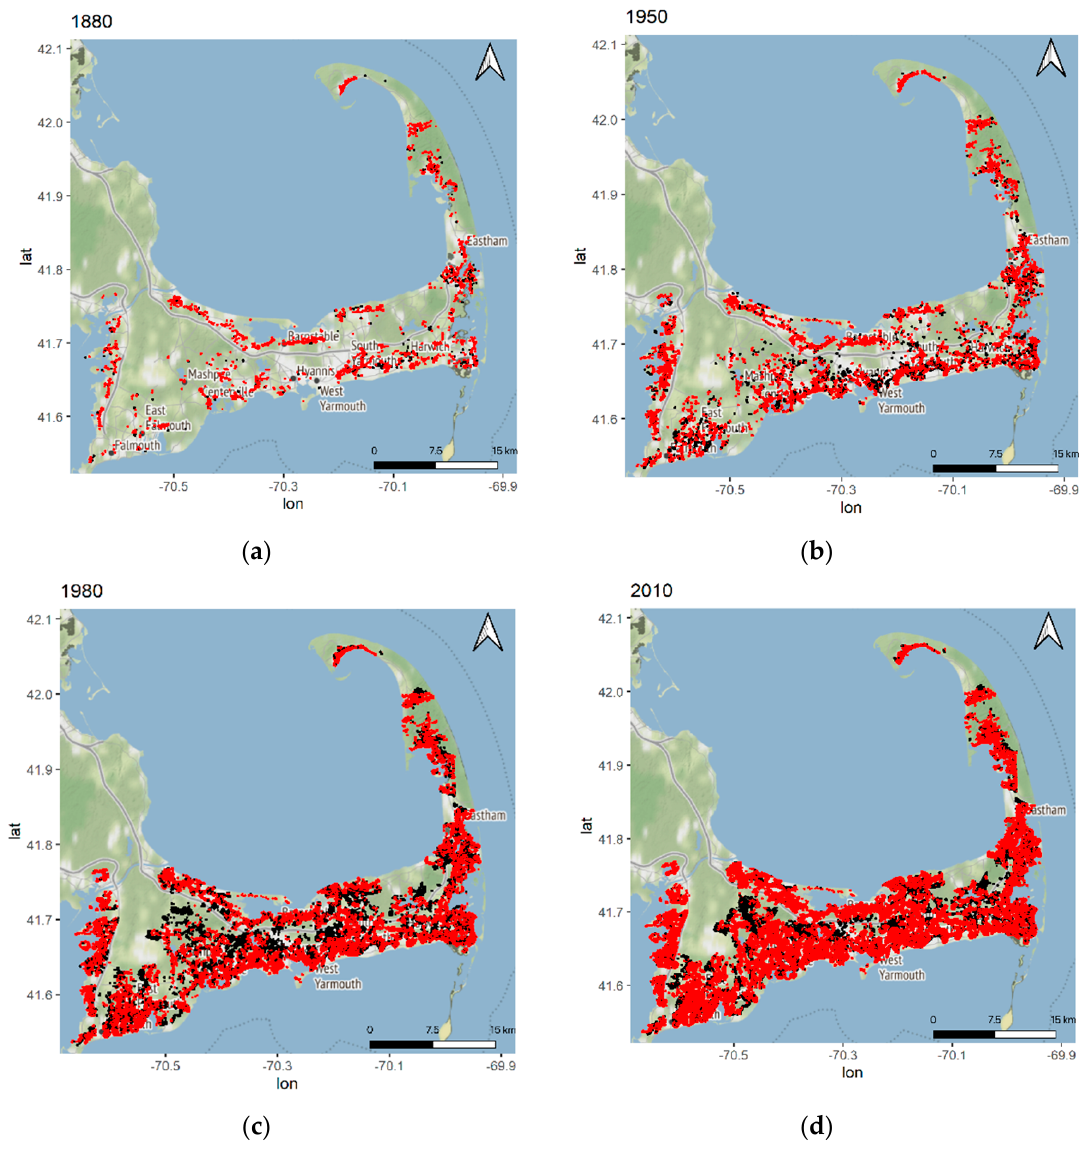
Figure 2. N load sources on Cape Cod from ( a ) 1880 to ( b ) 1950 to ( c ) 1980 to ( d ) 2010. Red dots indicate that N from that source is reaching the bay, while black dots indicate that the N from that source has not yet reached the bay by the year indicated in the map. Properties with direct discharge to the Atlantic Ocean are excluded. Table 1. Quantity and age of properties in embayments, and total estimated annual watershed nitrogen load to estuaries in equilibrium.